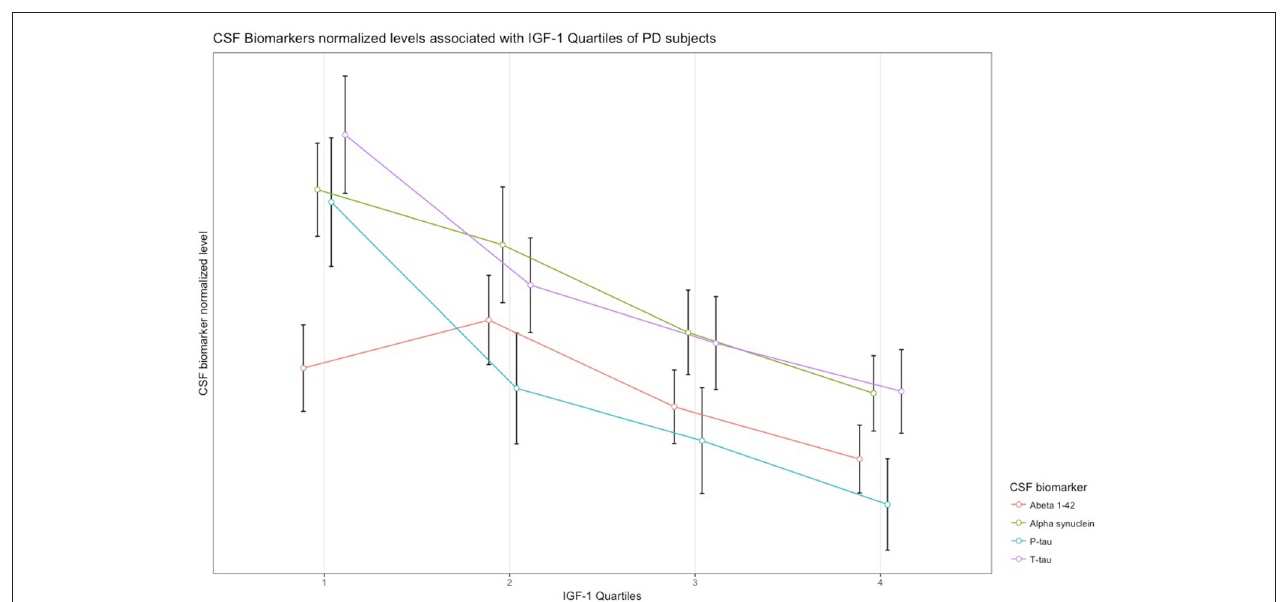
FIGURE 1 | Normalized levels of the CSF biomarkers associated with IGF-1 quartiles in patients with PD.